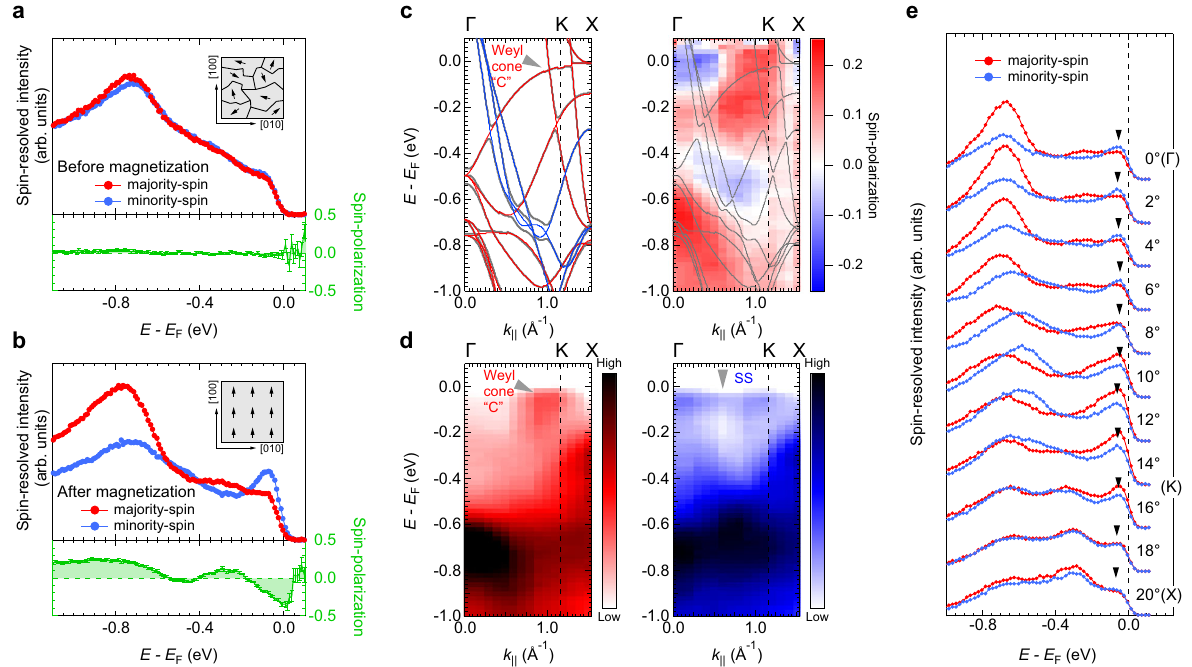
Fig. 4 Spin-polarized Weyl cone and fl at band surface state of Co 2 MnGa fi lm. a , b Spin-resolved EDCs and spin-polarizations at θ ∣∣ = − 4 ∘ ( k ∣∣ ~ − 0. 3 Å − 1 ) taken before and after magnetization at 80 eV with p -polarized light. All error bars represent standard deviation. The insets show the schematics of multi- magnetic domains and a single-magnetic domain. c Calculated band dispersion with E F shifted upward by 70 meV (left) and spin-polarization map along the Γ – K – X line (right). d Spin-resolved ARPES images of the majority (left) and minority (right) spin states. e Spin-resolved EDCs taken from θ ∣∣ = 0 ∘ to 20 ∘ ( Γ – K – X). The background signal of the secondary electrons was subtracted. Inverted triangles indicate the peak position of the minority spin-polarized fl at band.